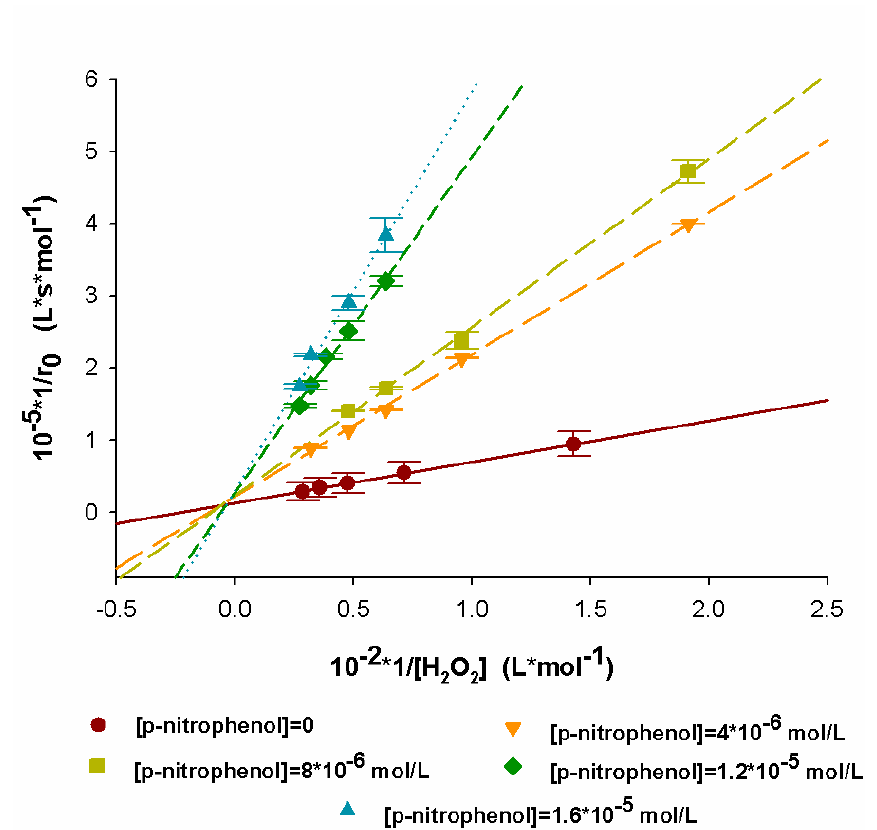
Fig. 2 Lineweaver – Burk graphs for H 2 O 2 decomposition in the presence of various concentra- tions of